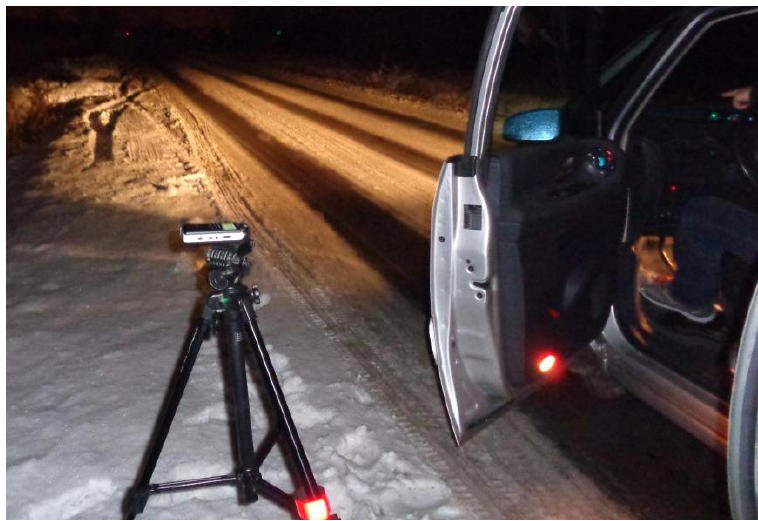
Figure 3. The road and the position of the audio recorder with built-in stereo microphones during on-road recordings in Lubartów in the winter.